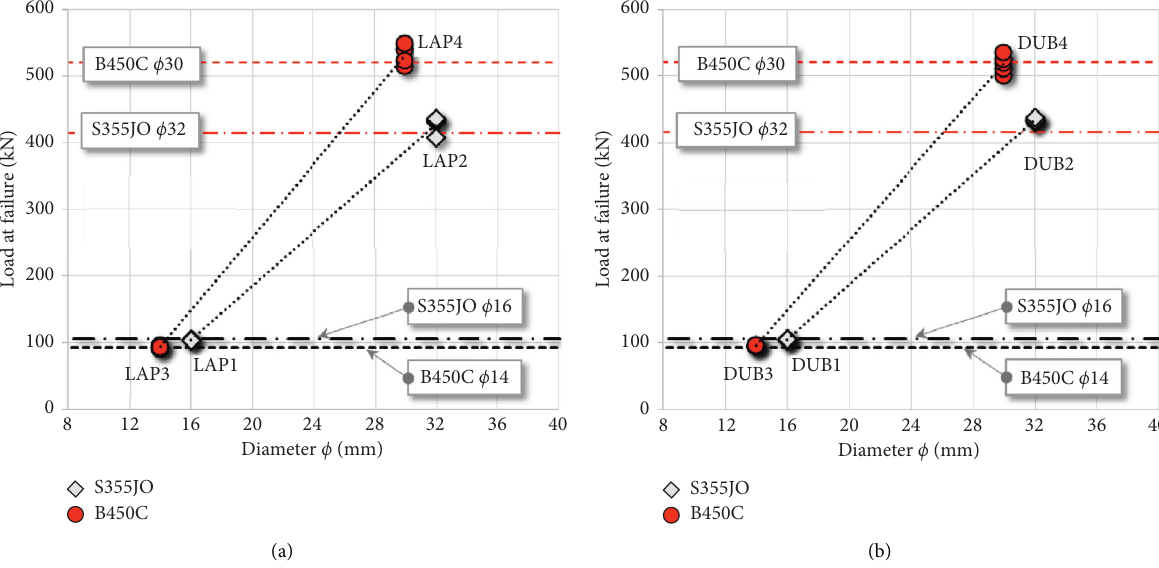
Figure 6: Results of experimental tests in terms of load corresponding to failure for the different specimens and comparison with reference data for micro-alloyed and ribbed bars for (a) lap joints and (b) dub joints.